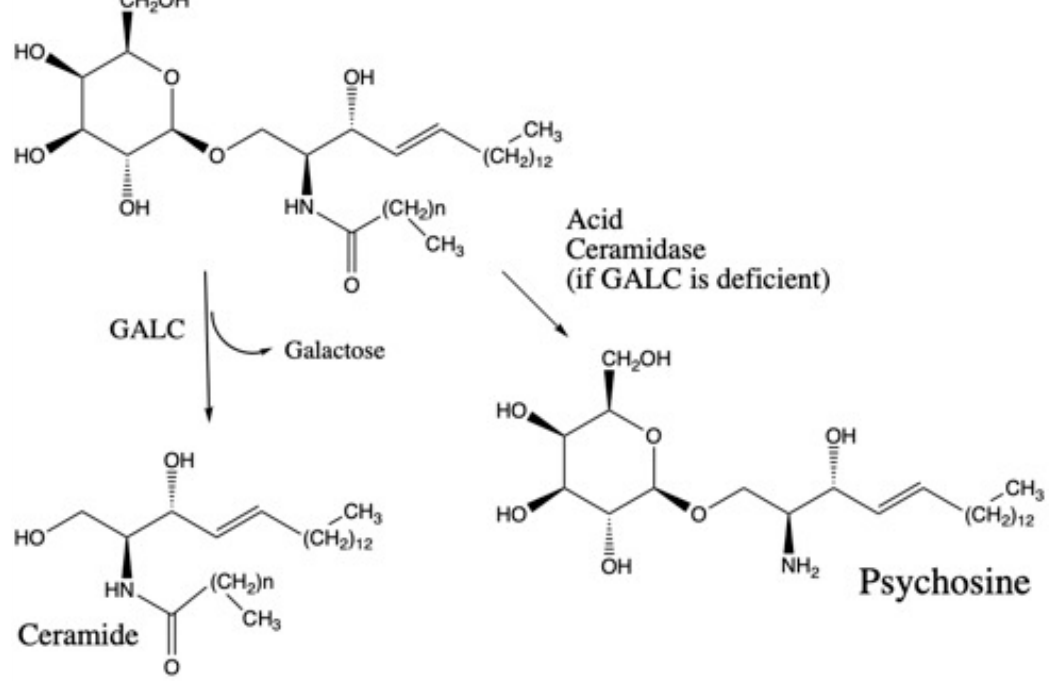
Figure 1. Galactocerebrosidase ( GALC)-catalyzed reaction and direct conversion of galactosylceramide to psychosine when GALC is deficient as proposed